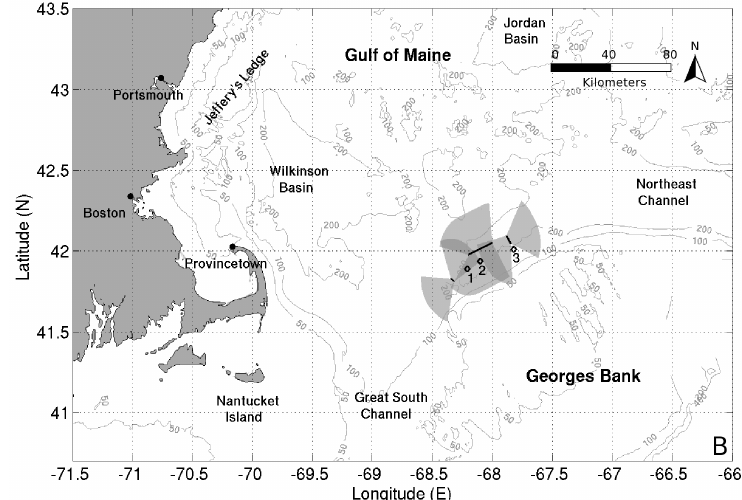
Figure A.2. Comparison between the measured normalized seafloor scattering and the modeled normalized scattered level in the New Jersey continental shelf at ( A ) 415 Hz using 198 radial beams, ( B ) 925 Hz using 187 radial beams and ( C ) 1,325 Hz using 381 radial beams as a function of the total travel time (Section 3.1). The darker regions in the measured scattered field level indicate a higher density of data points. The standard deviation of the measured level (vertical tick marks) is calculated from all the data points that fall within the travel time corresponding to an OAWRS range resolution [9] seconds around a given travel time. The total travel time is the two-way travel time from the source to the seafloor and from the seafloor to the